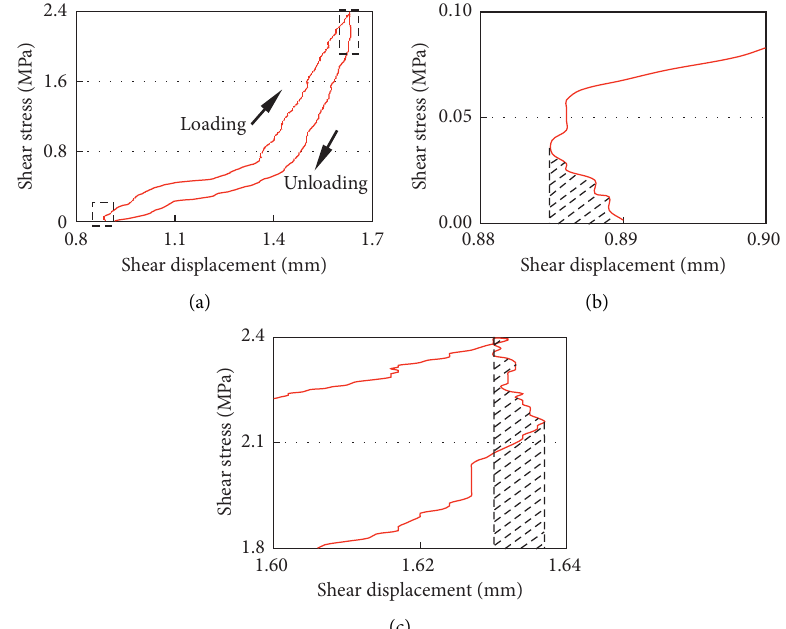
Figure 13: T - δ curves for sample TJ-1 at the 8th cycle. (a) Curve of the full loading-unloading process. (b) Enlarged curve around loading point. (c) Enlarged curve around unloading